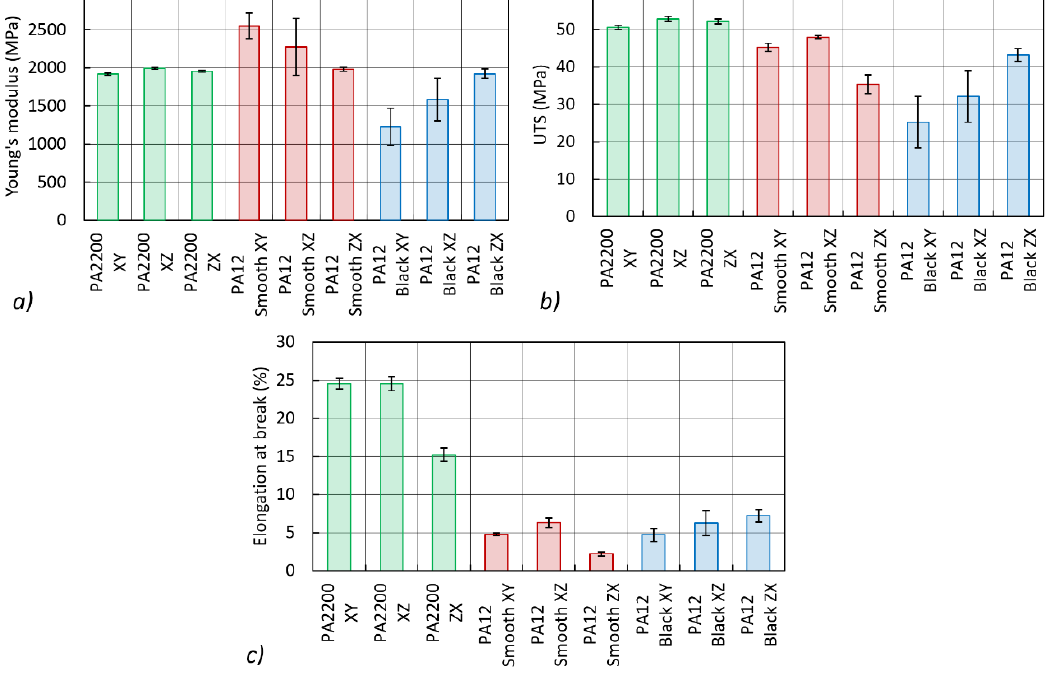
Figure 7. Results of mechanical testing presented as: ( a ) Young’s modulus, ( b ) Ultimate Tensile Strength and ( c ) Elongation at break of the PA2200, PA12 Smooth and PA12 Black with distinction of the build orientation.